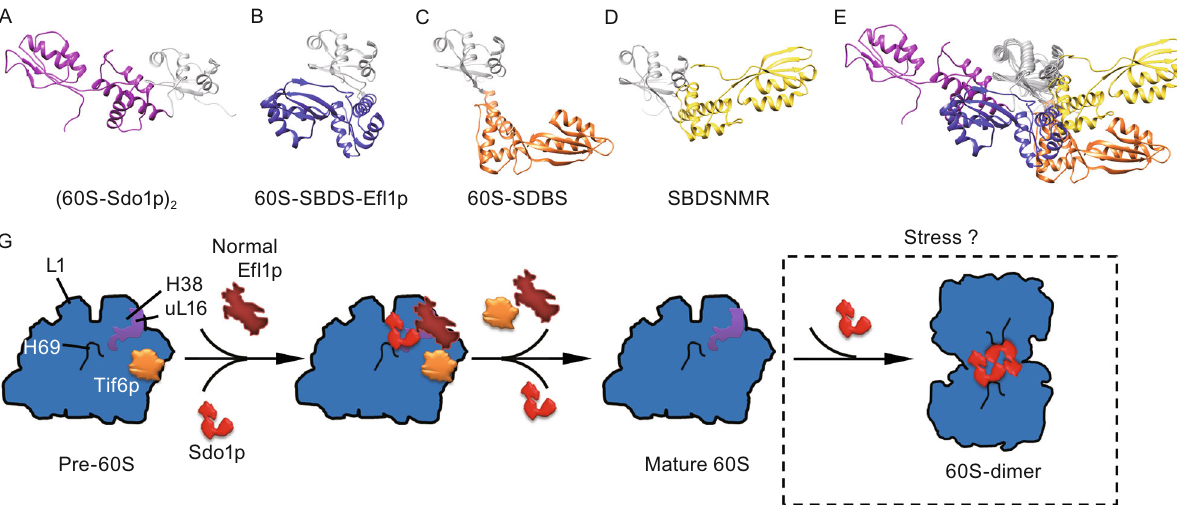
Figure 6. Proposed model of the action of Sdo1p in the late-stage maturation of the 60S subunit. (A – E) Conformational states of Sdo1p/SBDS. Coordinates of SBDS in heterologous 60S-SBDS-E fl 1p (B) and 60S-SBDS (C) complexes were taken from a very recent cryo-EM work (Weis et al., 2015). One snapshot of NMR structures of human SBDS (D) was taken from a previous study (de Oliveira et al., 2010). All the structures were aligned using the domain I of Sdo1p/SBDS as reference. (G) In normal condition, Sdo1p, as a member of a conformational signal relay system, probes the maturation status of the ribosomal P-site, and passes the signal to E fl 1p to release Tif6p from the nearly mature 60S subunit. Under a certain stress, Sdo1p might induce the formation of inactive 60S dimers to limit the cellular